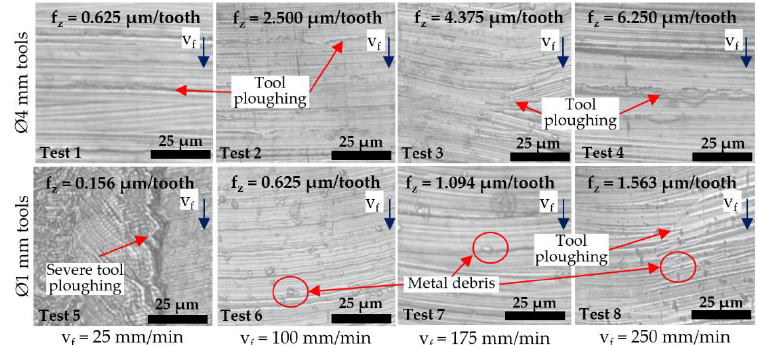
Figure 11. Optical micrographs of machined surfaces at the end of each test.